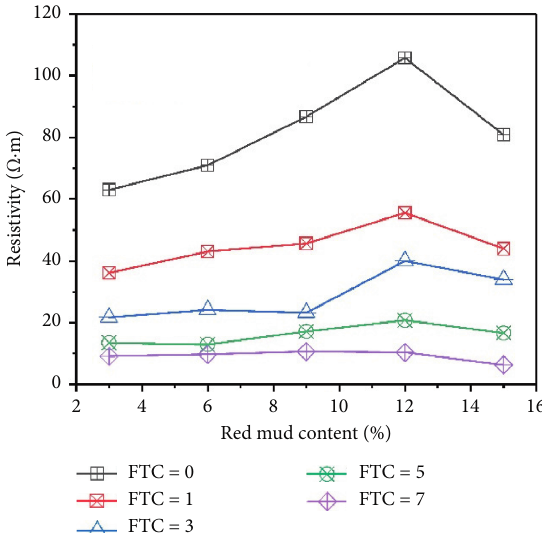
Figure 9: The relationship between resistivity and red mud content under the freezing-thawing red mud content of 12%, but there still exists a peak value.